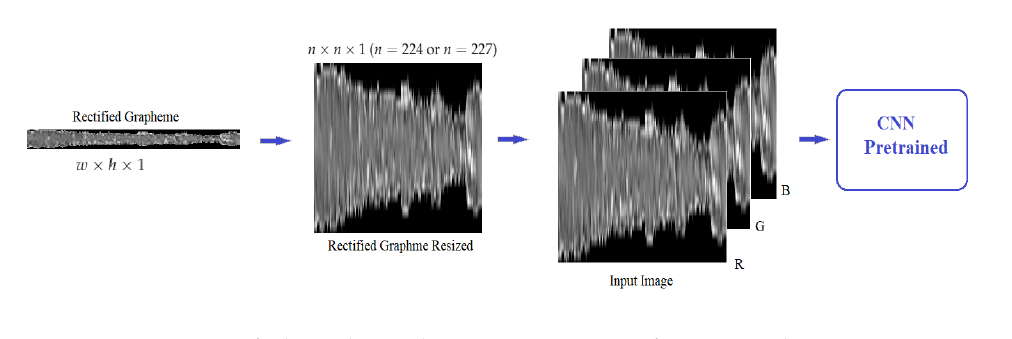
Figure 6. Rectified Simple Grapheme Resizing Process for Pretrained CNN Input.